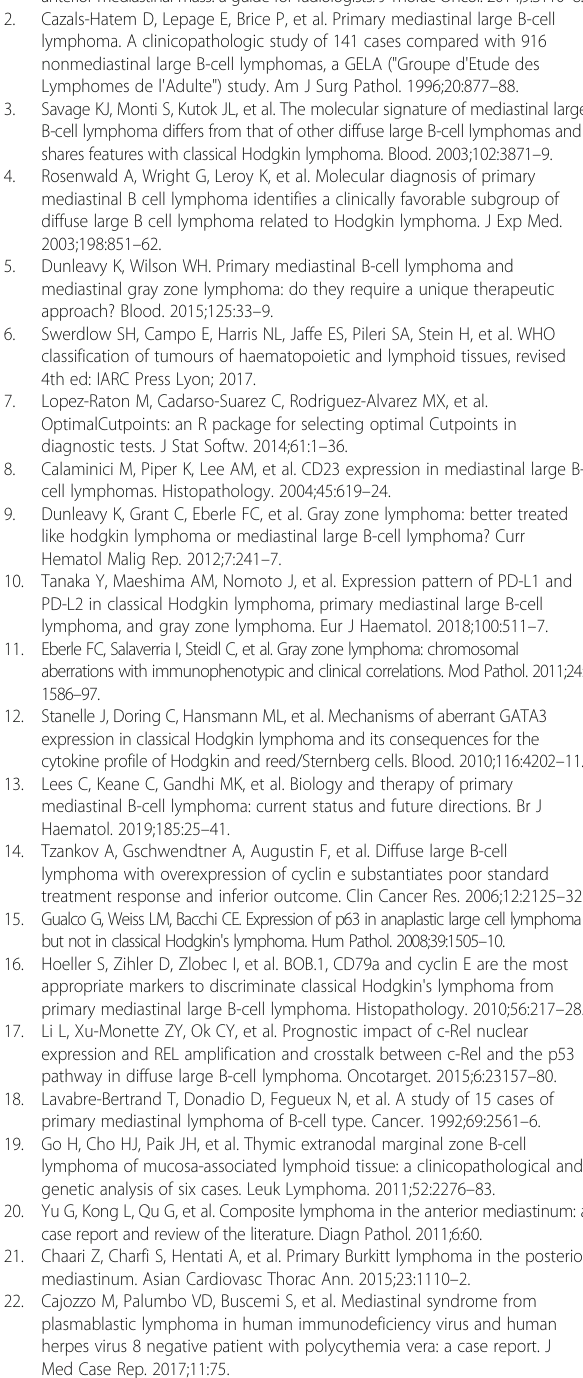
Additional file 1: Table S1. Expression of p63 and GATA3 between mediastinal and non-mediastinal Hodgkin lymphoma. Additional file 2: Table S2. Expression of p63 and GATA3 between mediastinal and non-mediastinal B-cell